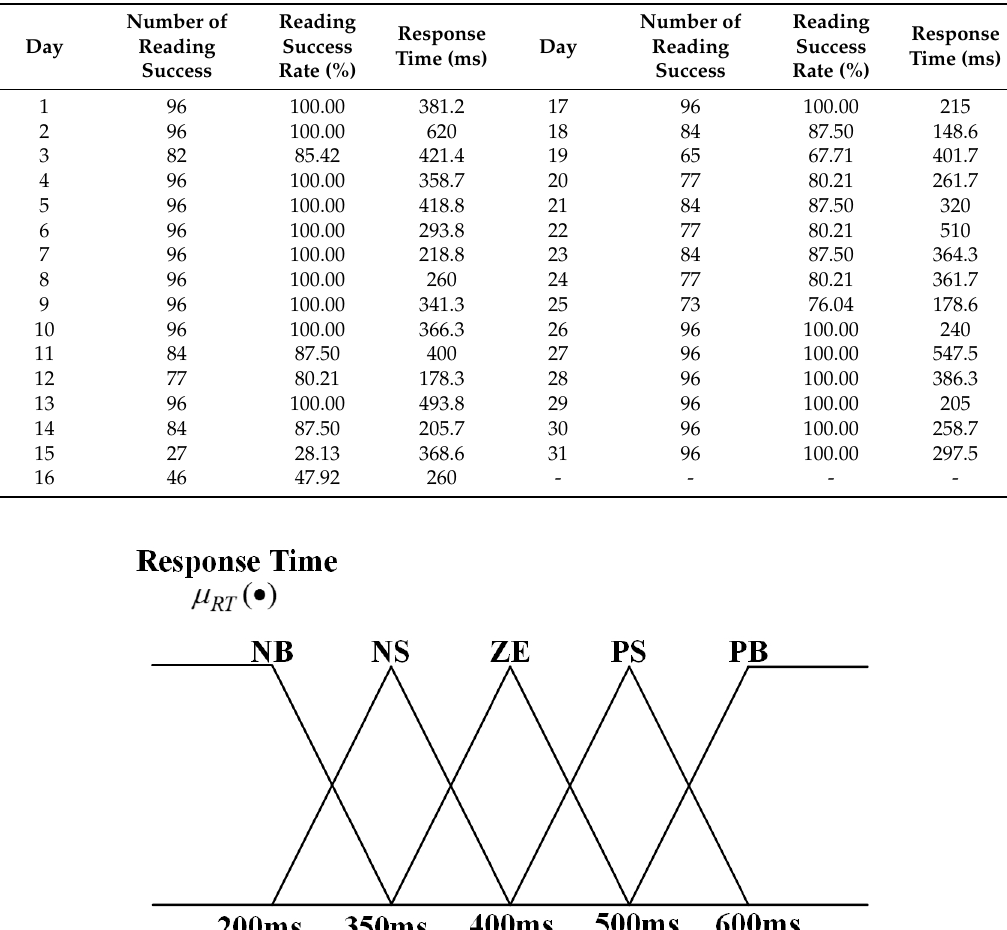
Table 5. Field Measurements of M 1 for the Actual Small-Scale PLC-based AMI.